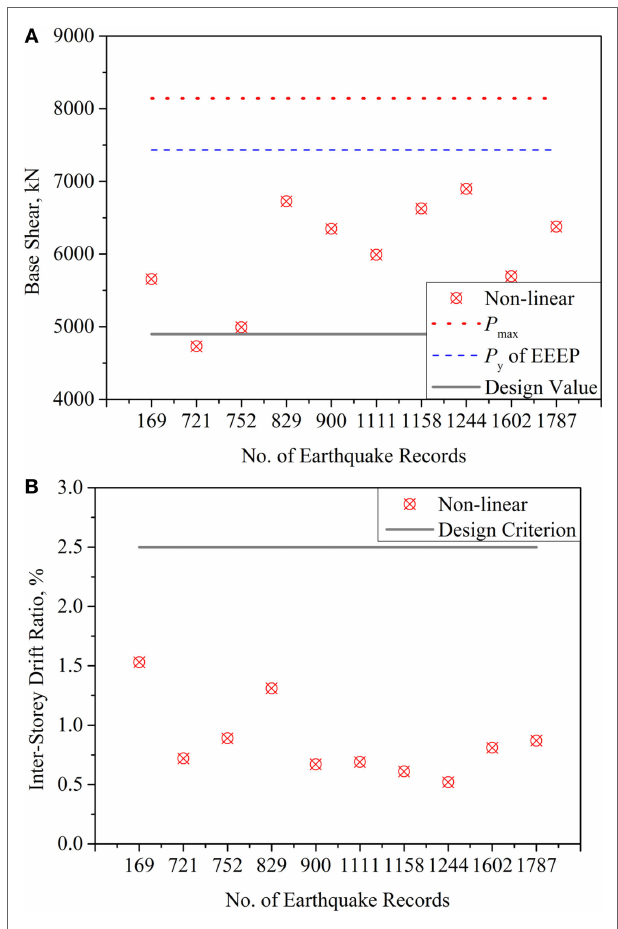
FigUre 12 | Summary of responses of the CHECKER building to 10 earthquake excitations: (a) base shear and (B) inter-storey drift